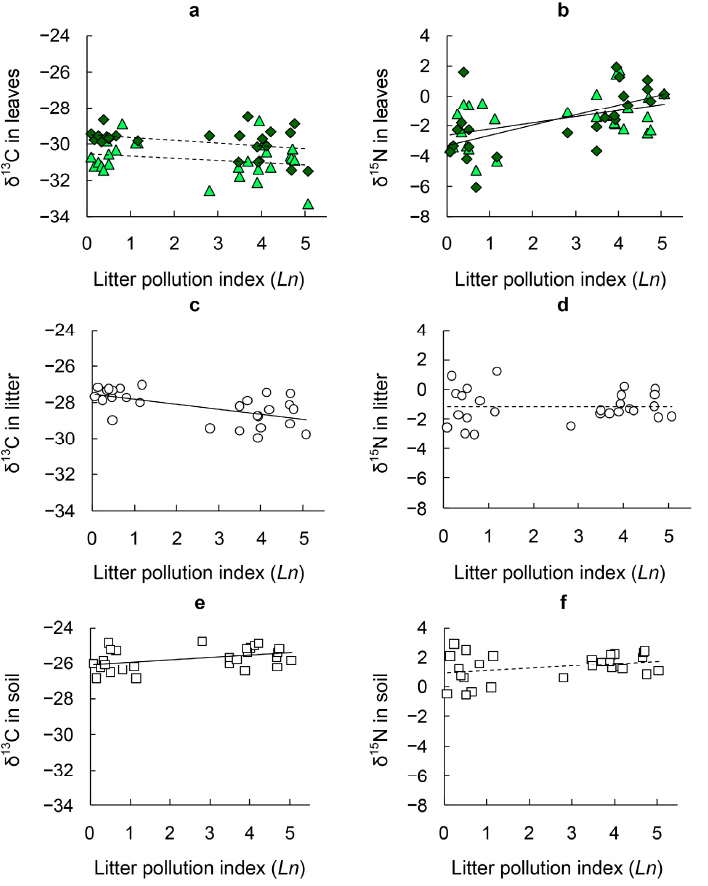
Figure 3. The dependencies of δ 13 C ( a , c , e ) and δ 15 N ( b , d , f ) content in the leaves ( a , b ), litter ( c , d ) and soil humus horizon ( e , f ) on the index of litter pollution with heavy metals. Additional symbols: light-green triangles— Betula spp.; dark-green diamonds— Pinus sylvestris . Solid lines—statistically significant values; dotted lines—statistically insignificant values.